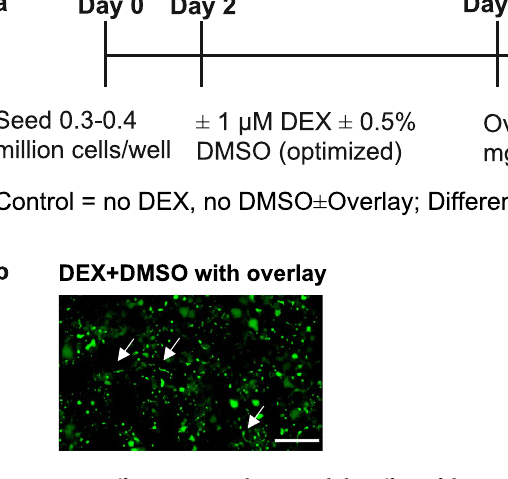
Figure 1. Differentiation scheme and the effect of dexamethasone (DEX) and DMSO-mediated differentiation on canalicular formation in HuH-7 cells. ( a ) Schematic depicting HuH-7 differentiation and culture timeline with 1 µM DEX and 0.5% DMSO supplementation and Matrigel overlay. Extended culture was performed for 2 weeks. ( b ) Formation of canalicular-like structures was examined using 5(6)-carboxy-2 ′ ,7 ′ -dichlorofluorescein diacetate (CDFDA) in differentiated HuH-7 cells with overlay. Uptake of CDFDA occurs passively into the cell, where intracellular esterase enzymes cleave the diacetate group. The resulting CDF is a fluorescent substrate for apical MRP2-mediated efflux into canalicular-like structures highlighted in green (arrows). Scale bar = 200